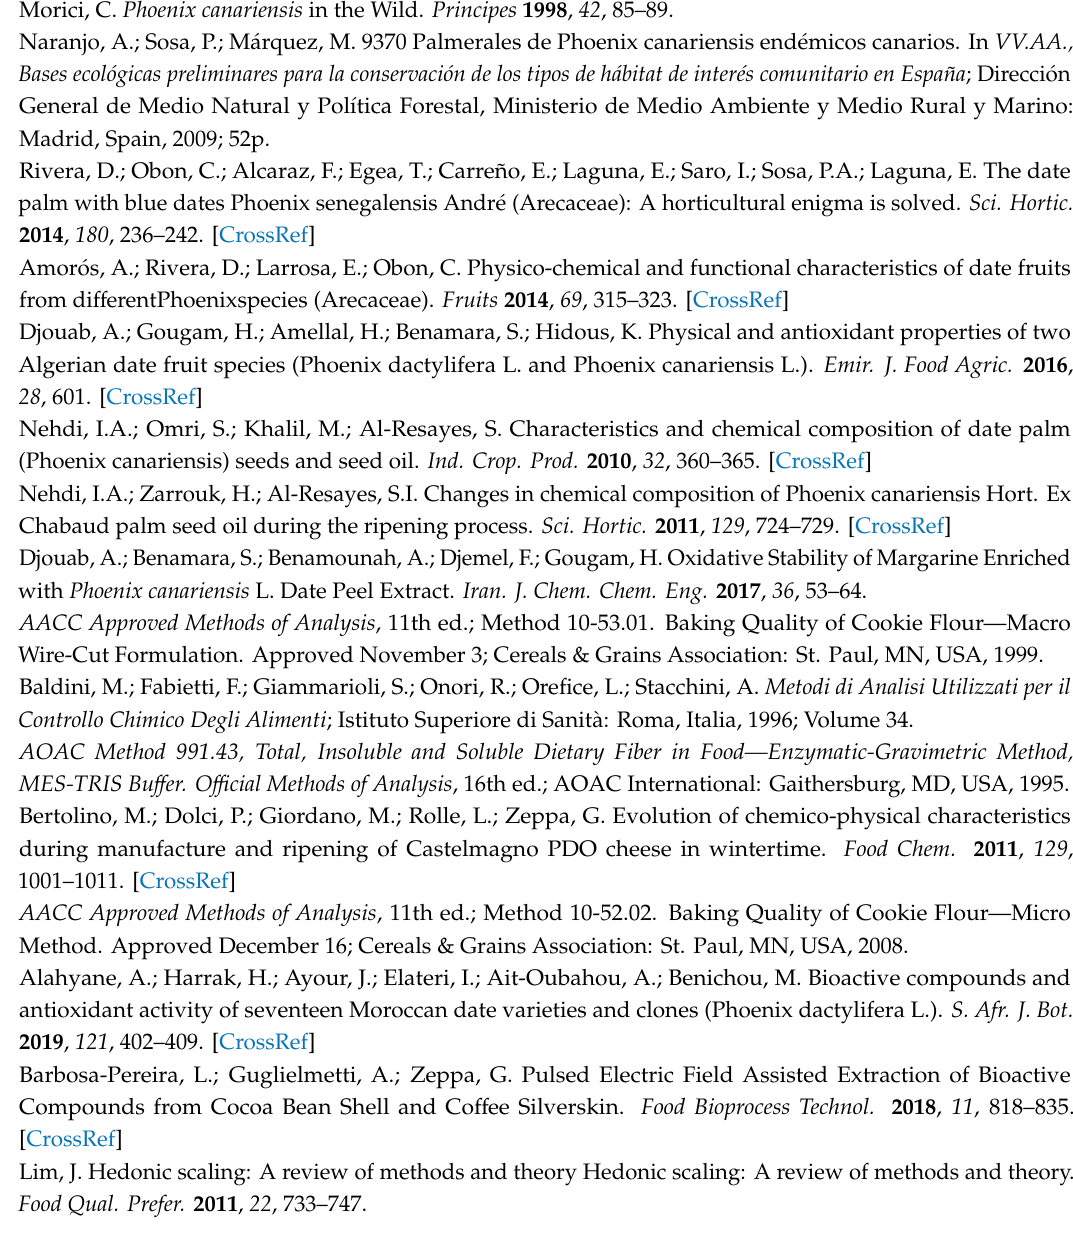
Table S1: Chromatographic parameters of polyphenolic compounds detected on RP-HPLC–PDA in P. canariensis date